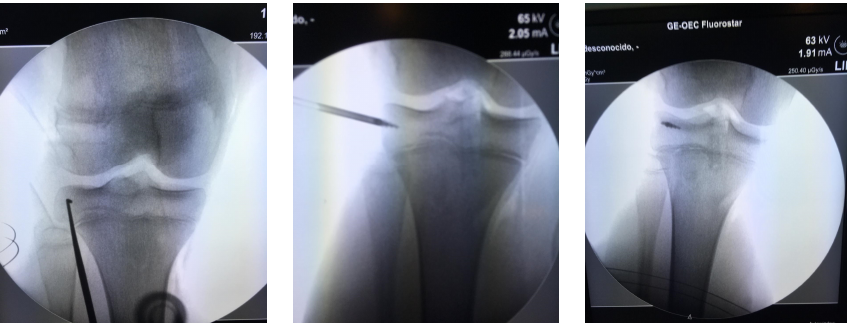
Figure 5. ACL reconstruction on physis open patients. Under fluoroscopic control on the operating, selection of the footprint and intruction the TWINFIX for LET reconstruction.